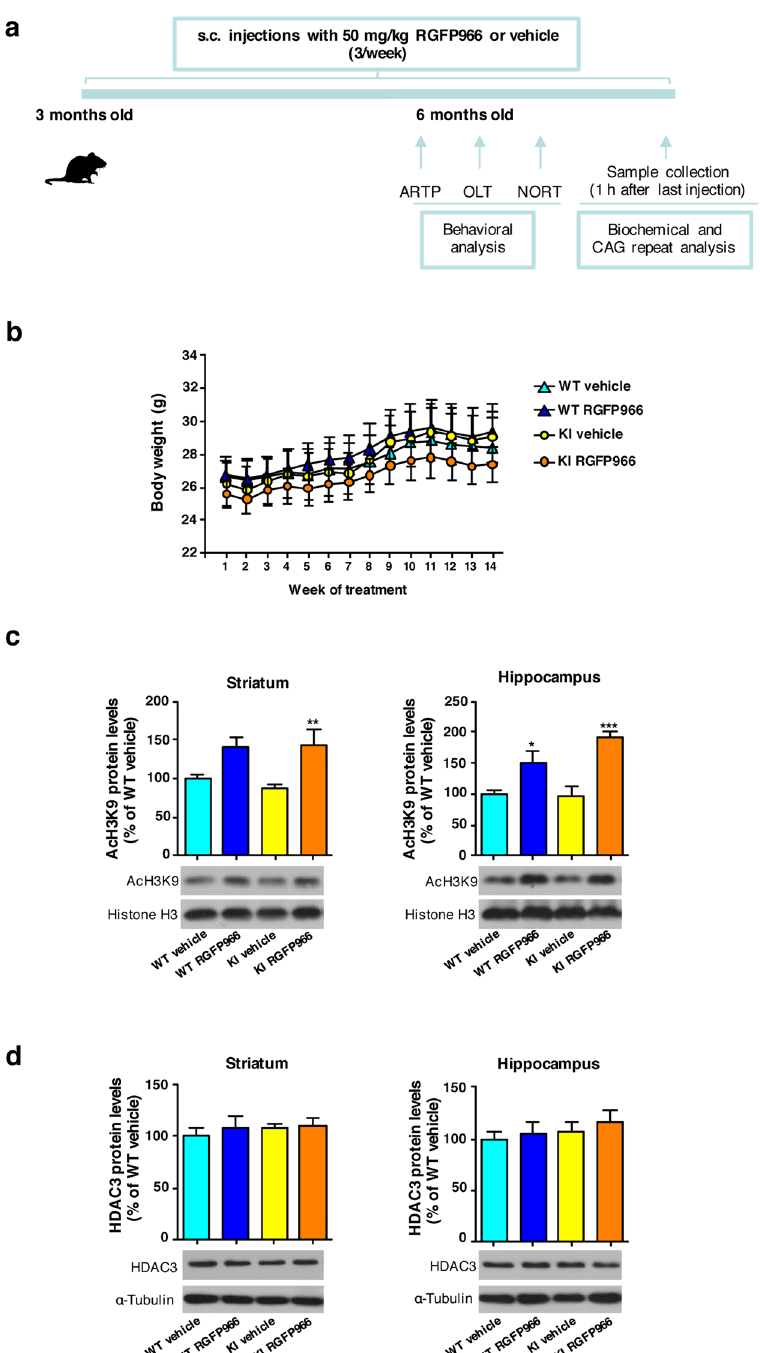
Figure 1. Systemic RGFP966 treatment efficiently inhibits hippocampal and striatal HDAC activity. (a) Schematic of chronic treatment and experimental plan. ARTP, accelerating rotarod task procedure; OLT, object location task; NORT, novel object recognition task. ( b) Body weight measurements. Data represent the mean ± SEM (n = 6–10). ( c) Representative immunoblots showing histone H3 acetylation levels at position lysine 9 (AcH3K9) normalized to total histone H3 and (d) HDAC3 levels normalized to α -tubulin in striatal and hippocampal extracts from vehicle and RGFP966 chronically treated wild type Hdh Q7/Q7 (WT) and mutant Hdh Q7/Q111 (KI) mice. The blots in (c) and (d) are cropped; full-length images are provided in Supplementary Figure 2. * p < 0.05; ** p < 0.01; *** p < 0.001 compared to vehicle-treated mice by two-way ANOVA with Bonferroni post-hoc analysis. Data represent the mean ± SEM (n = 4–7 per